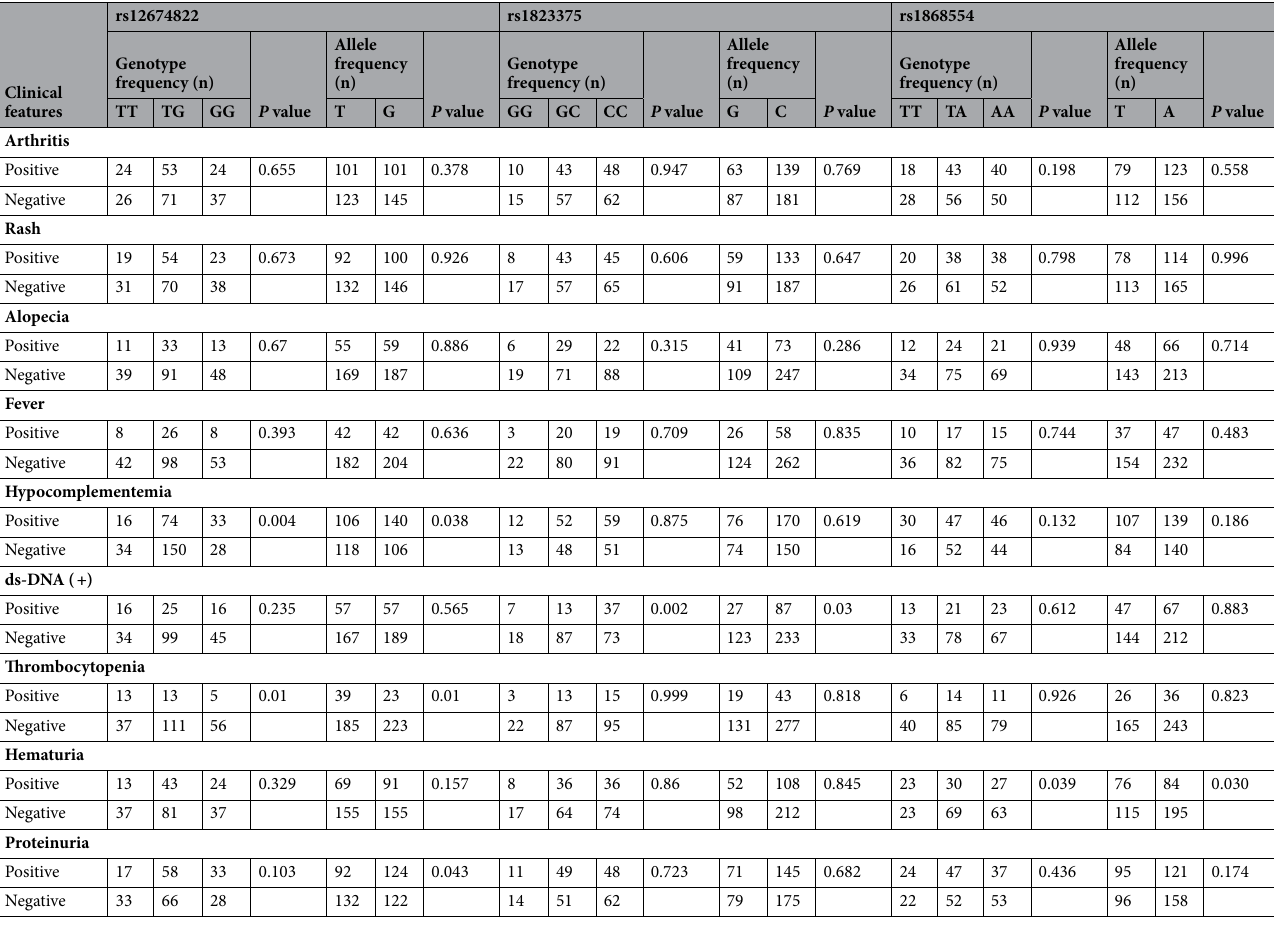
Table 4. Association between clinical, laboratory features and allele and frequencies of rs12674822, rs1823375, rs1868554 polymorphisms of Ang2 gene in SLE. SLE, systemic lupus